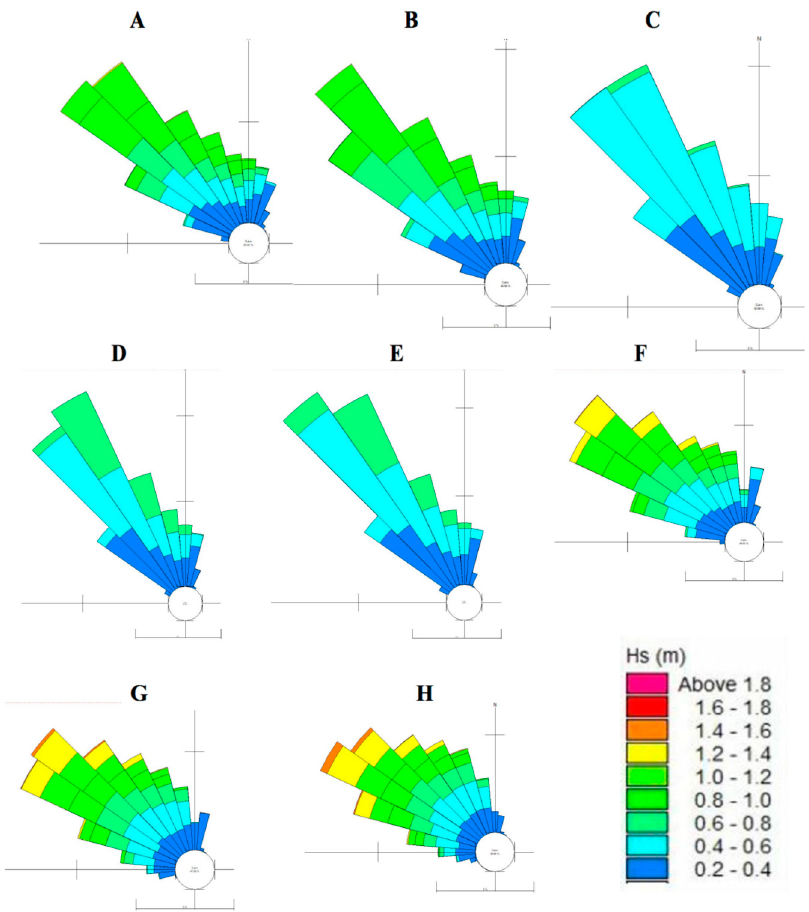
Figure 7. Wave climate at the eight virtual buoys, indicated as A–H in Figure 6, along Saadiyat